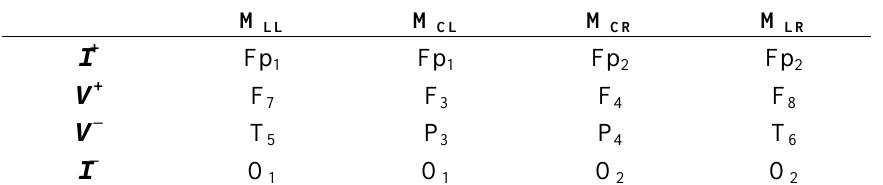
Table 1. Electrode positions according to 10–20 electrode positioning system.